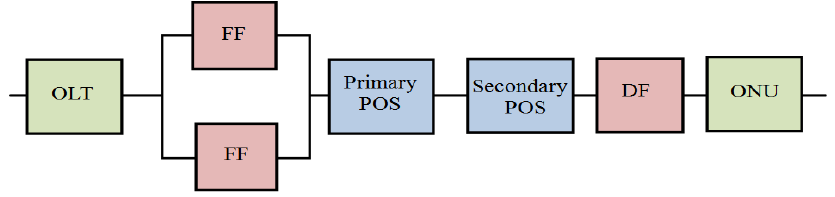
Figure 10. Reliability block diagram for feeder fiber (FF) protection architecture.